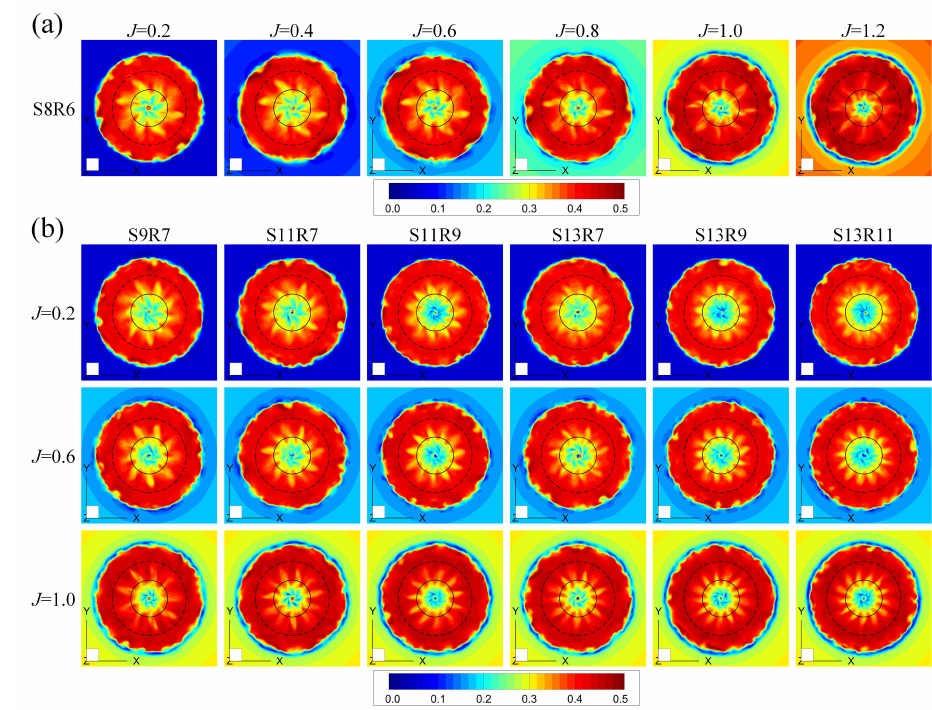
Figure 22. Velocity magnitude V m at z = 0.5 D r slice, where the radii of dashed circle and solid circle are 0.30 D r and 0.15 D r , respectively. ( a ) PJP model S8R6, ( b ) derived PJP models ID 2-7.